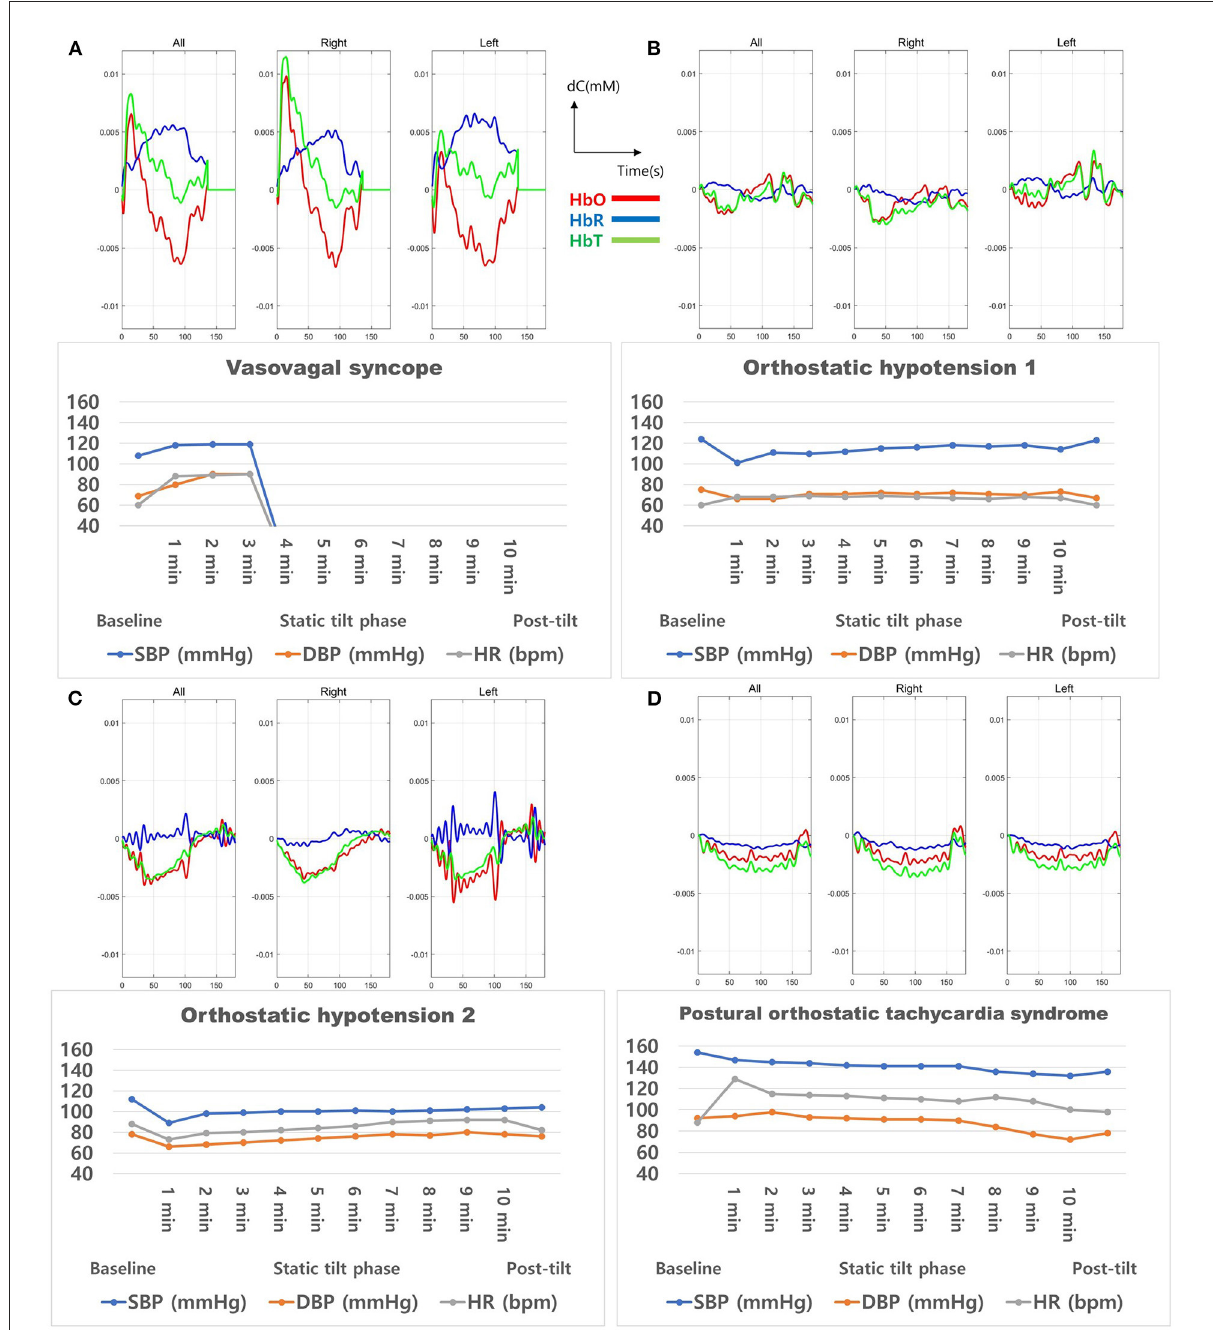
FIGURE7 Cerebral oxygenation during the 3-min static tilt phase in burn patients with abnormal results in the head-up tilt table test. These four patients presented (A) vasovagal syncope, (B) orthostatic hypotension 1, (C) orthostatic hypotension 2, and (D) postural orthostatic tachycardia syndrome. HbO, oxyhemoglobin; HbR, deoxyhemoglobin; HbT, total Hb concentration.